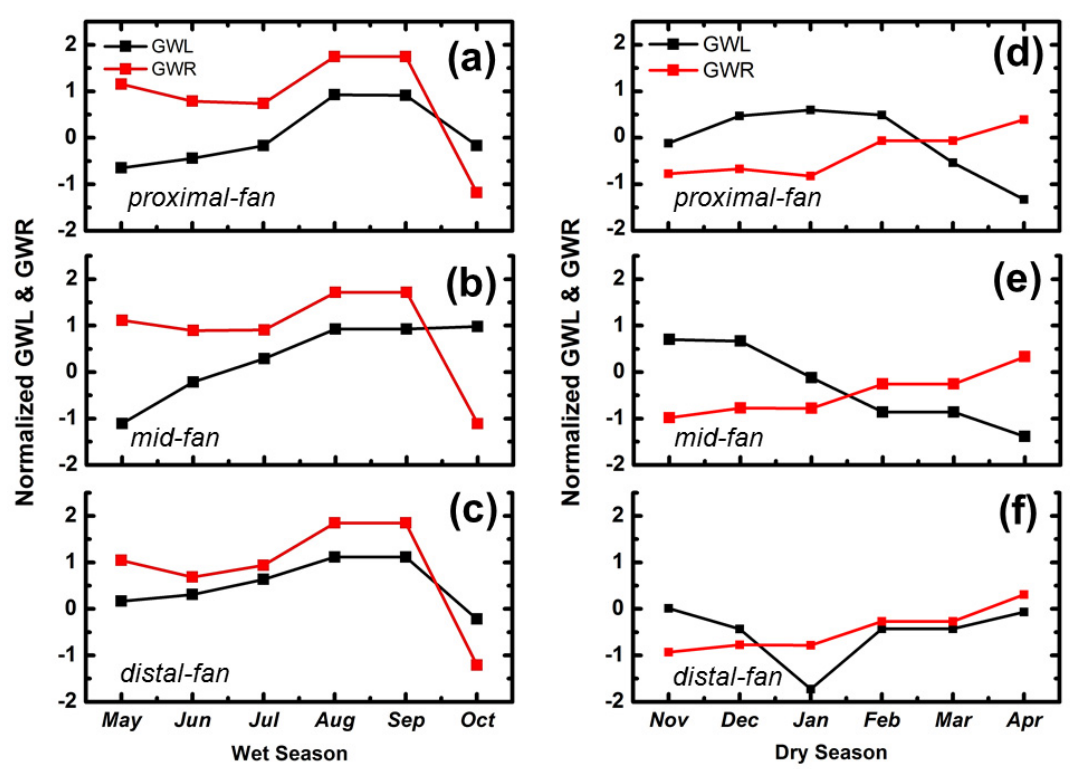
Figure 8. The temporal variations of the normalized GWL and GWR for the selected monitoring wells: ( a , d ) well 9100211 in the proximal fan area, ( b , e ) well 1004011 in the middle fan area, and ( c , f ) well 9180211 in the distal fan area. The land surface elevations for these monitoring stations in the proximal, middle, and distal fans are 179, 46, and 5 m, respectively.